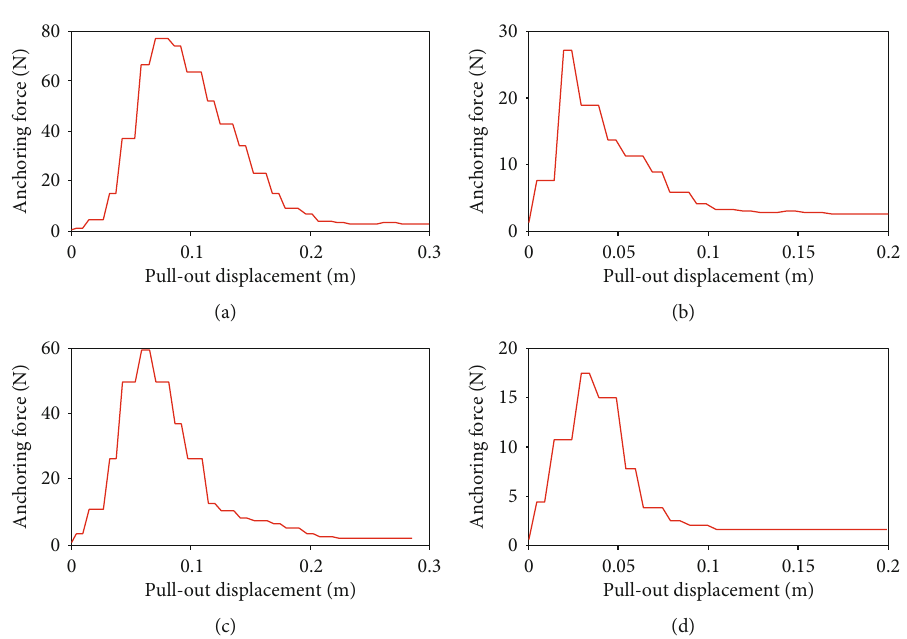
Figure 10: Anchoring experiments in fi ne sand (also called soft